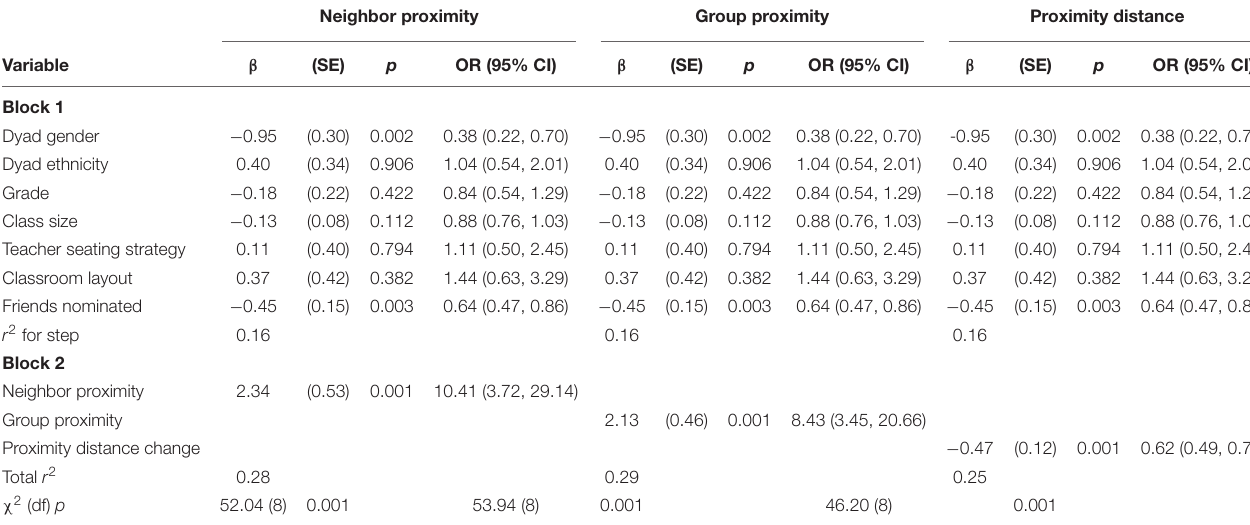
TABLE 3 | Longitudinal logistic regressions predicting new Time 2 outgoing friend nominations from changes in classroom seating: One randomly selected nomination per student. Neighbor proximity Group